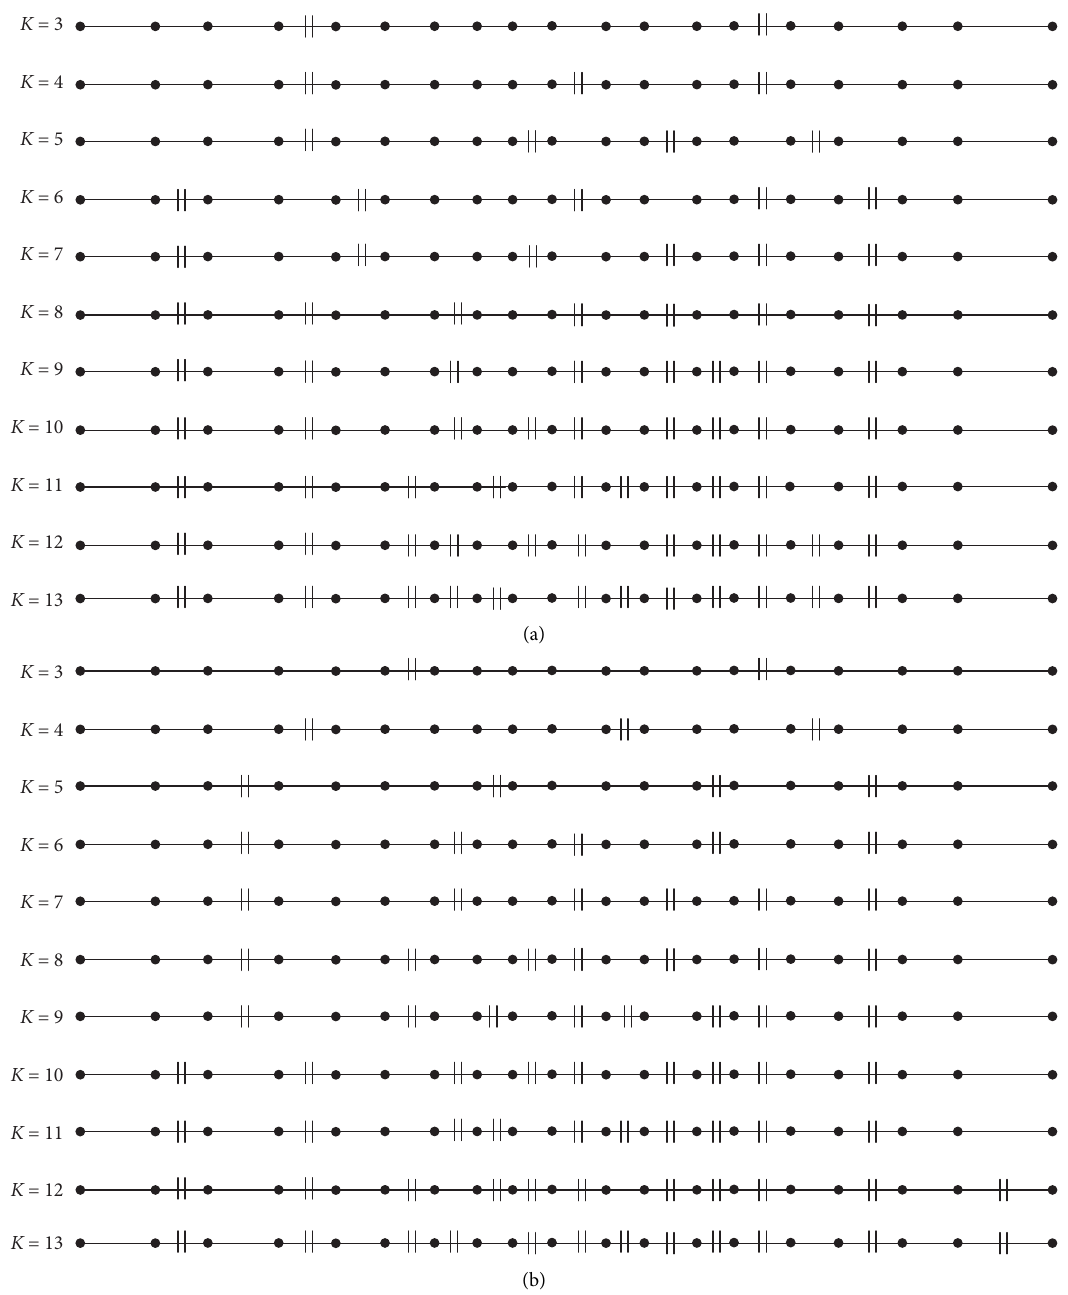
Figure 5: Optimal zone division schemes under b (b) Optimal zone division schemes under b